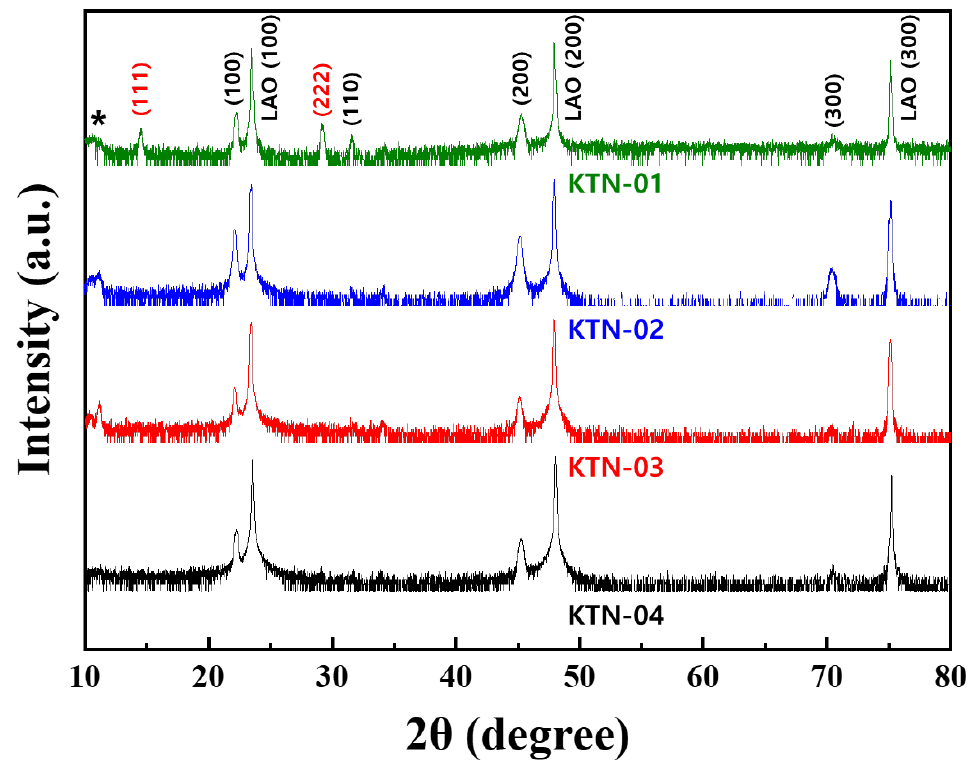
Figure 2. HRXRD patterns of KTN thin films deposited on LaAlO 3 substrate for 3 h depending on the RF power applied to targets. Black and red indices denote planes associated with perovskite and pyrochlore phases, respectively. Asterisk denotes unidentified peak which we presume to be a signature of the K-deficient phase.